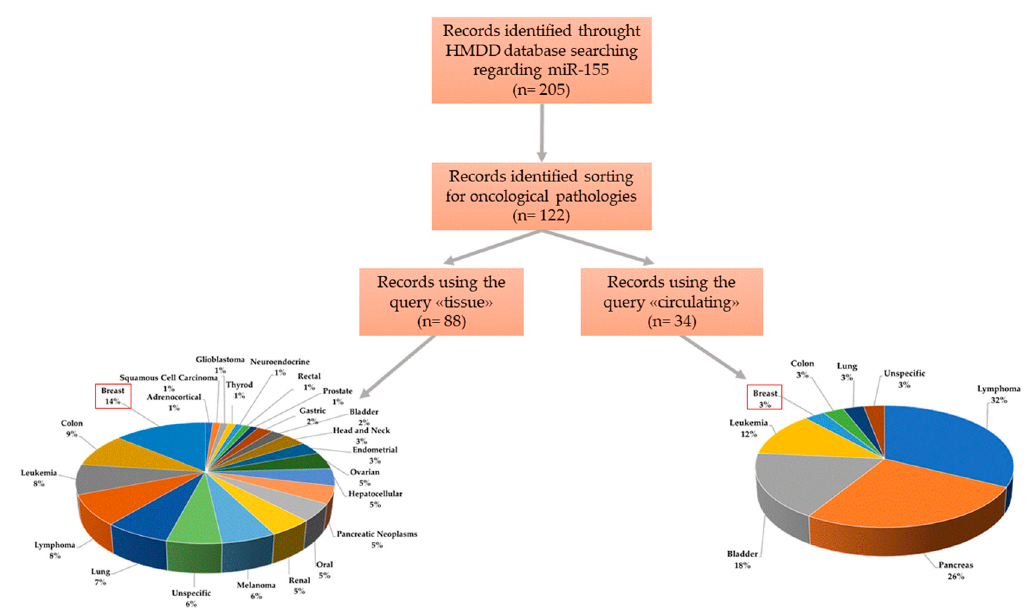
ff erent human oncological